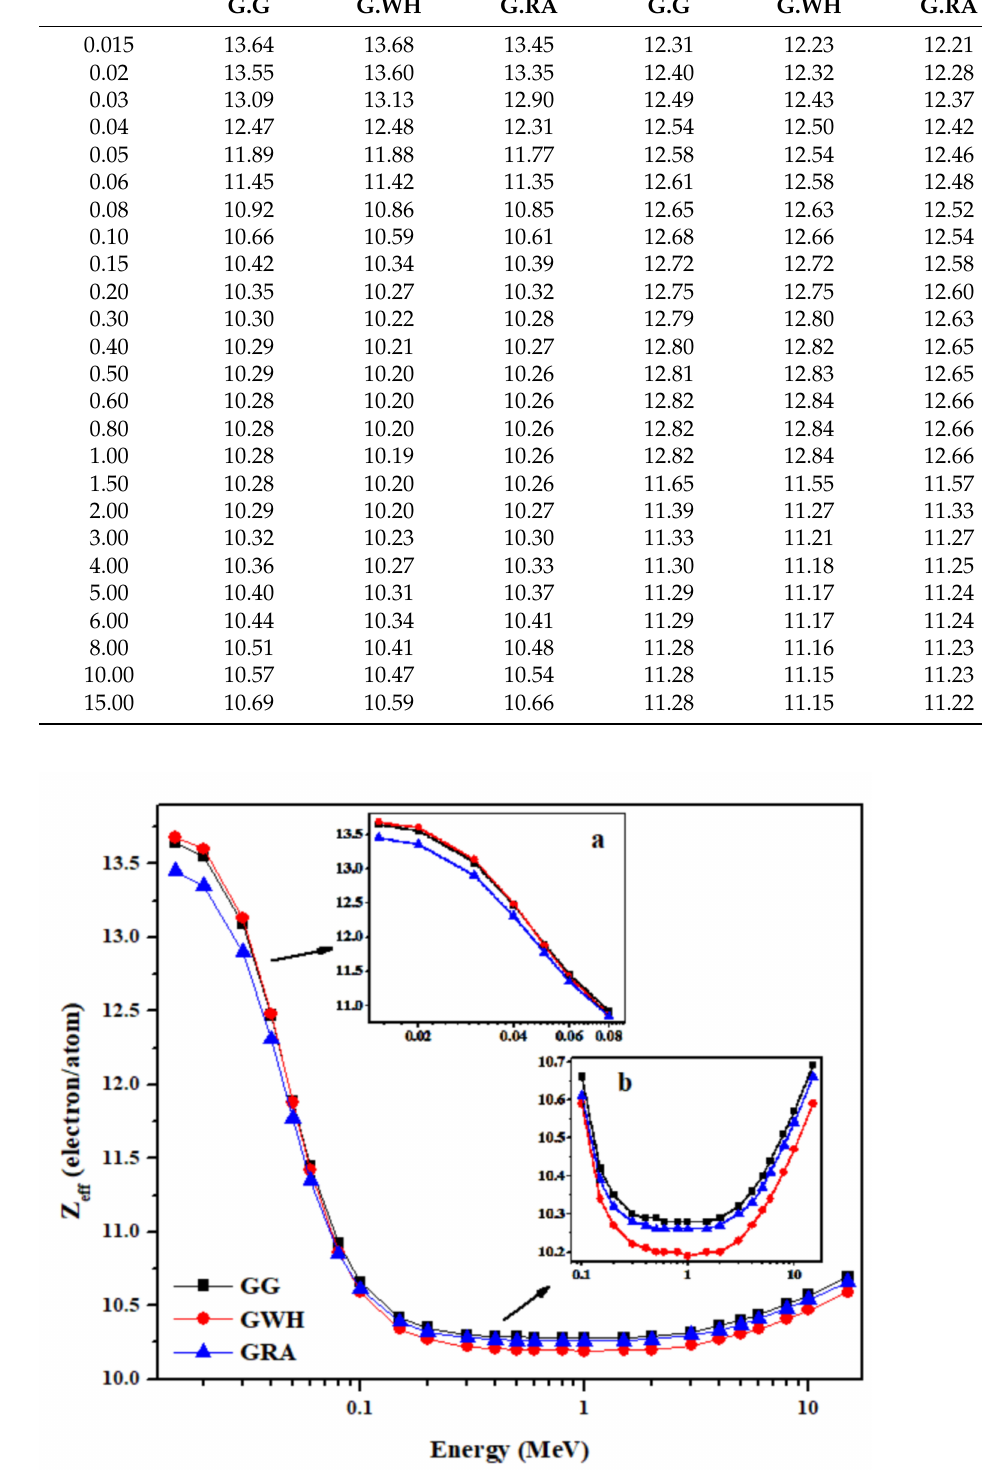
Figure 5. Variation of the calculated values of effective atomic number (Z eff ) with photon energy for the granite samples in the energy range 0.015 to 15 MeV. Insets ( a , b ) to the figure show the variation of the experimentally obtained Z eff in the low and high energy ranges,